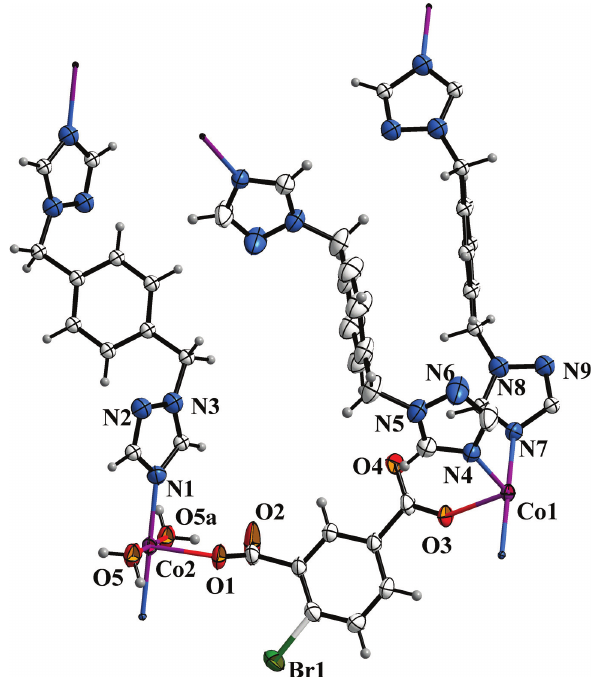
Table 1: Data collection and